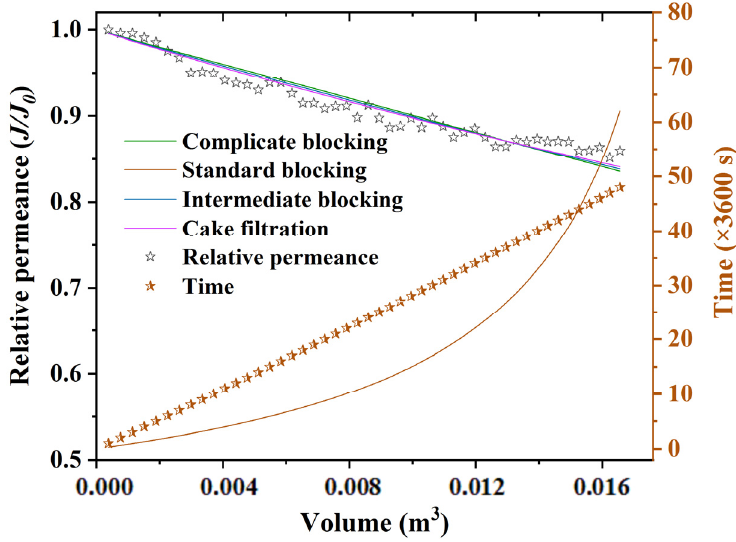
Figure 5. Fitting curves of membrane permeance under the optimal operating conditions based on membrane fouling models.